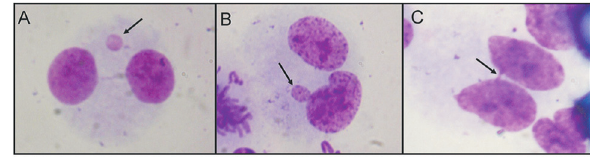
Figure 3 - Nuclear abnormalities detected by micronuclei test (arrows). (A) micronucleus; (B) nuclear bud; (C) nucleoplasmic